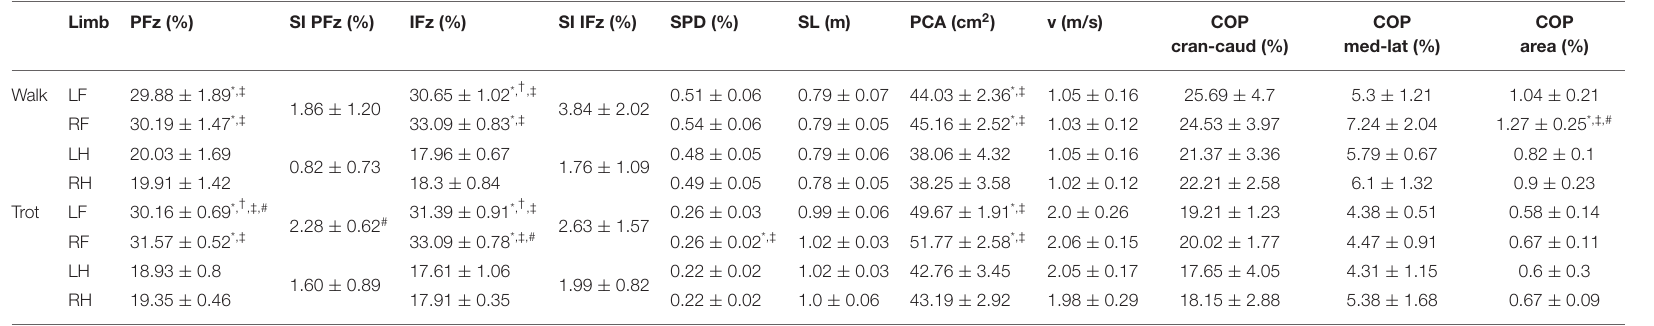
TABLE 5 | Mean ± standard deviation of all parameters for the condition “boots on the left hind limb.” Limb PFz (%)